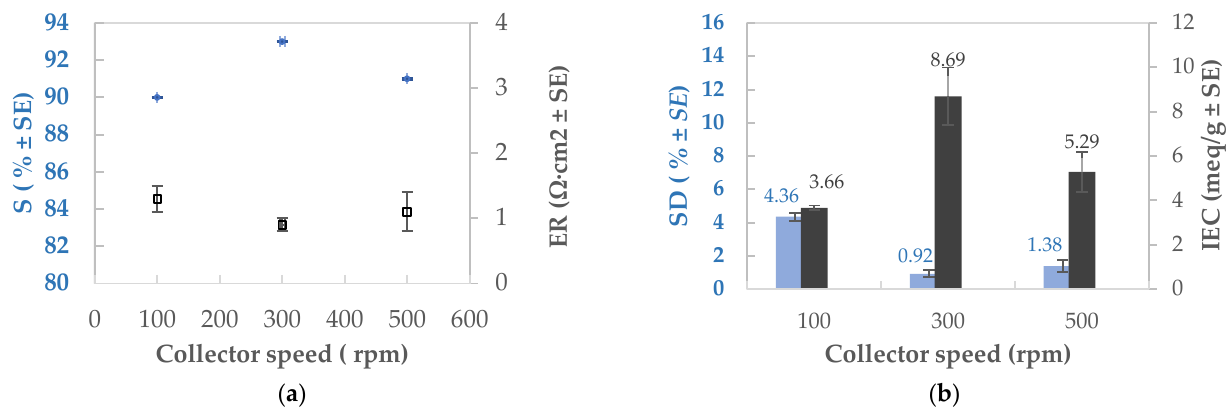
Figure 6. Influence of the collector velocity on the AEM properties: ( a ) SD and IEC; ( b ) S and ER.